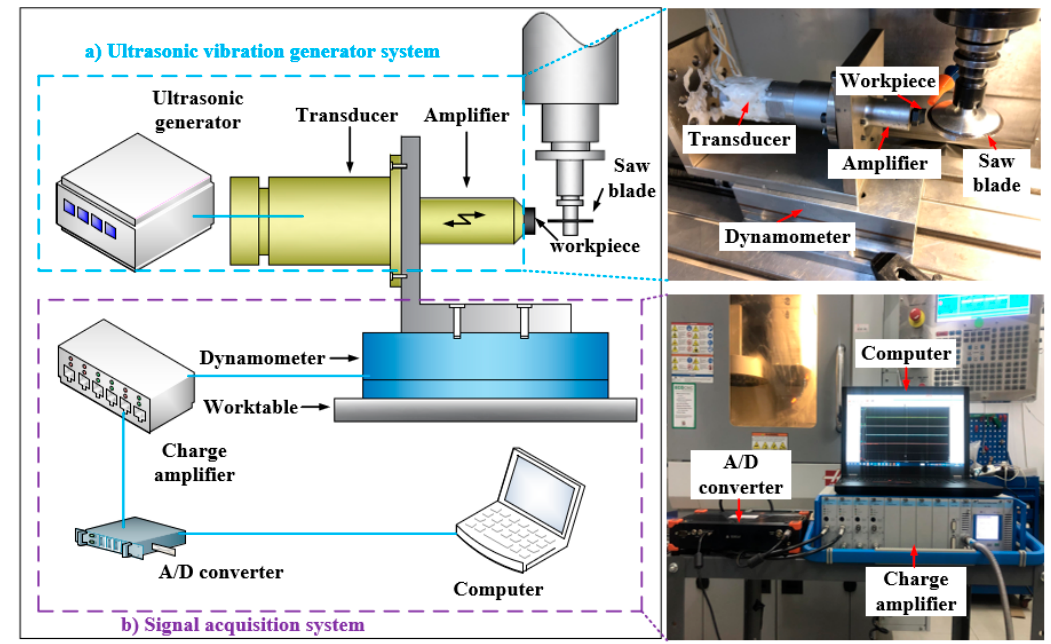
Table 2. The test parameters.